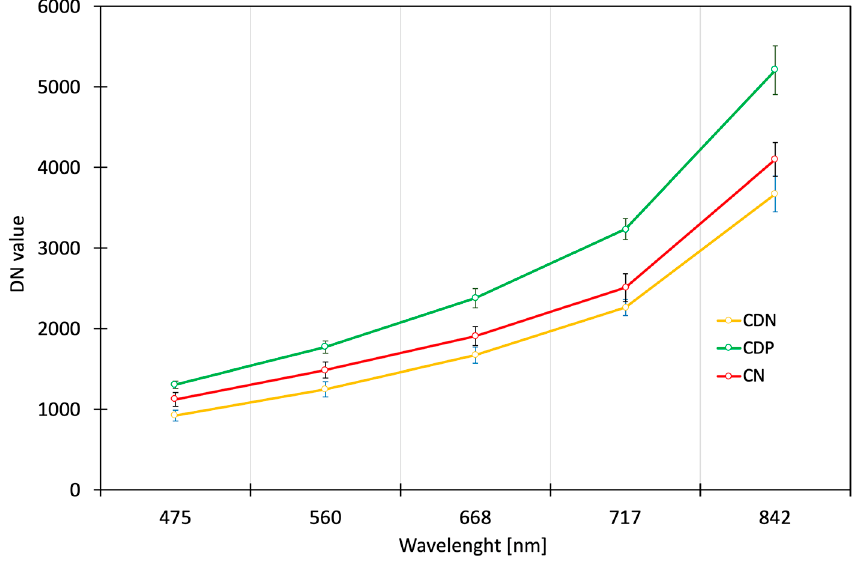
Figure 7. Graphs of the spectral curves for the three compartments analysed in the bioreactor.